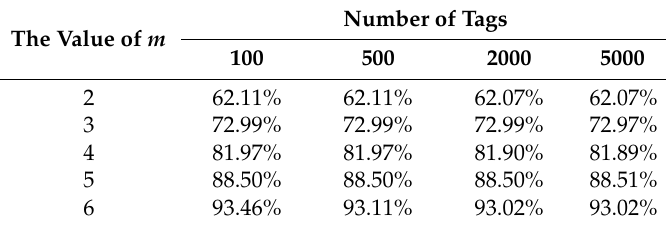
Table 7. The theoretical value of identification